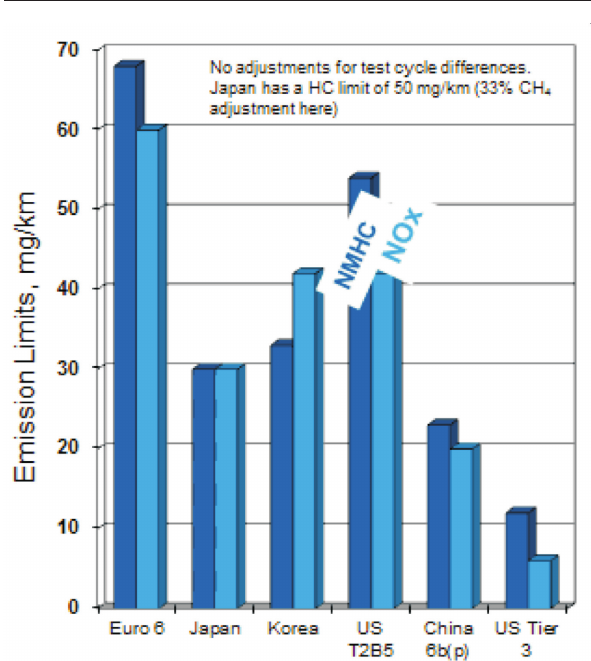
Figure 1. Relative comparison of key gasoline LD vehicle non-methane hydrocarbon (NMHC) and NO